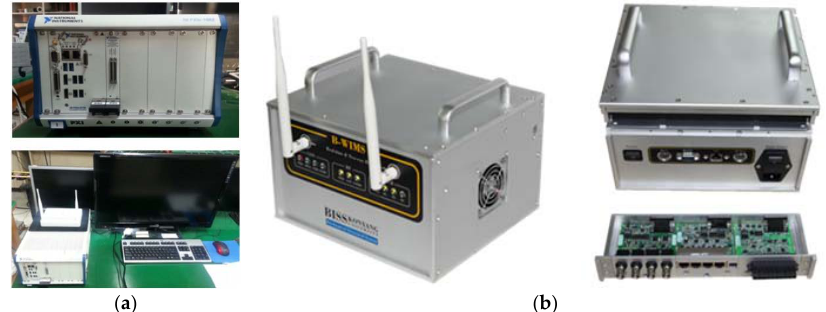
Figure 2. Component of H/W of the WUMS: ( a ) Host PC; ( b ) target.